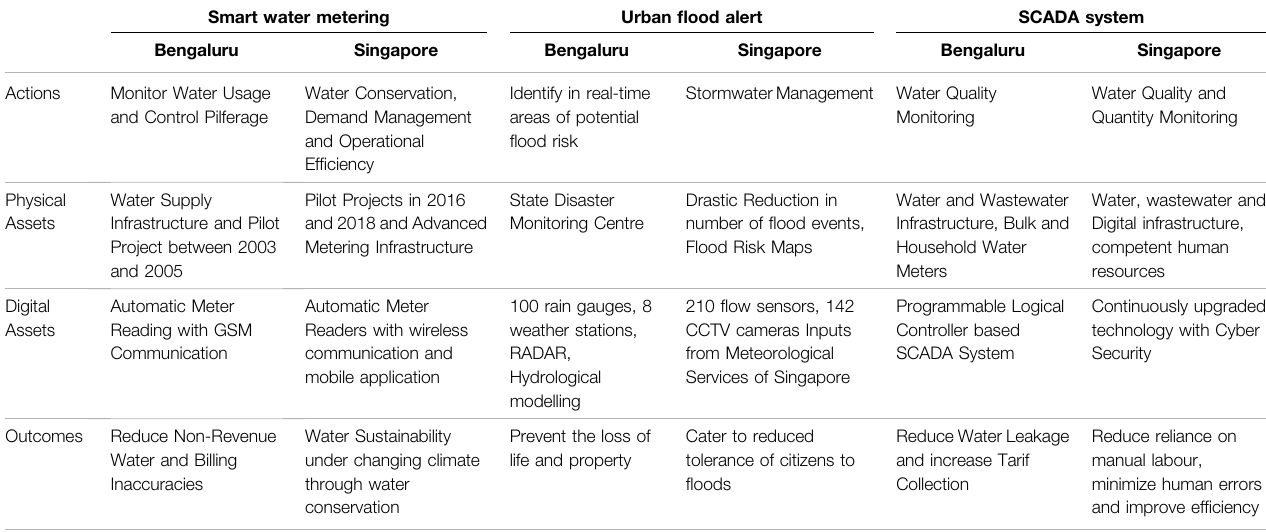
TABLE 2 | Comparison of the adoption and implementation of the three technologies between the two cities of Bengaluru and Singapore across four key aspects. Smart water